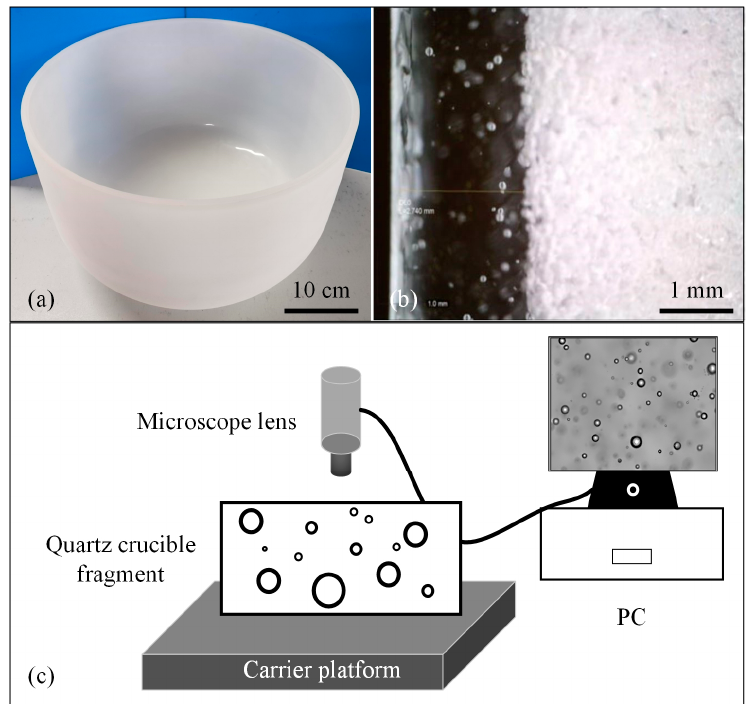
Figure 1. Image acquisition. ( a ) Picture of quartz crucible; ( b ) Double structure inside the quartz crucible; ( c ) Schematic diagram of the acquisition system.